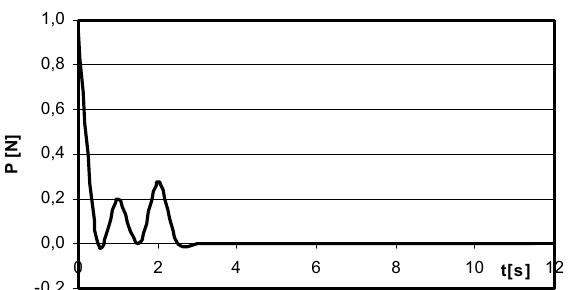
Fig. 4. Optimal control for impact absorber (Case